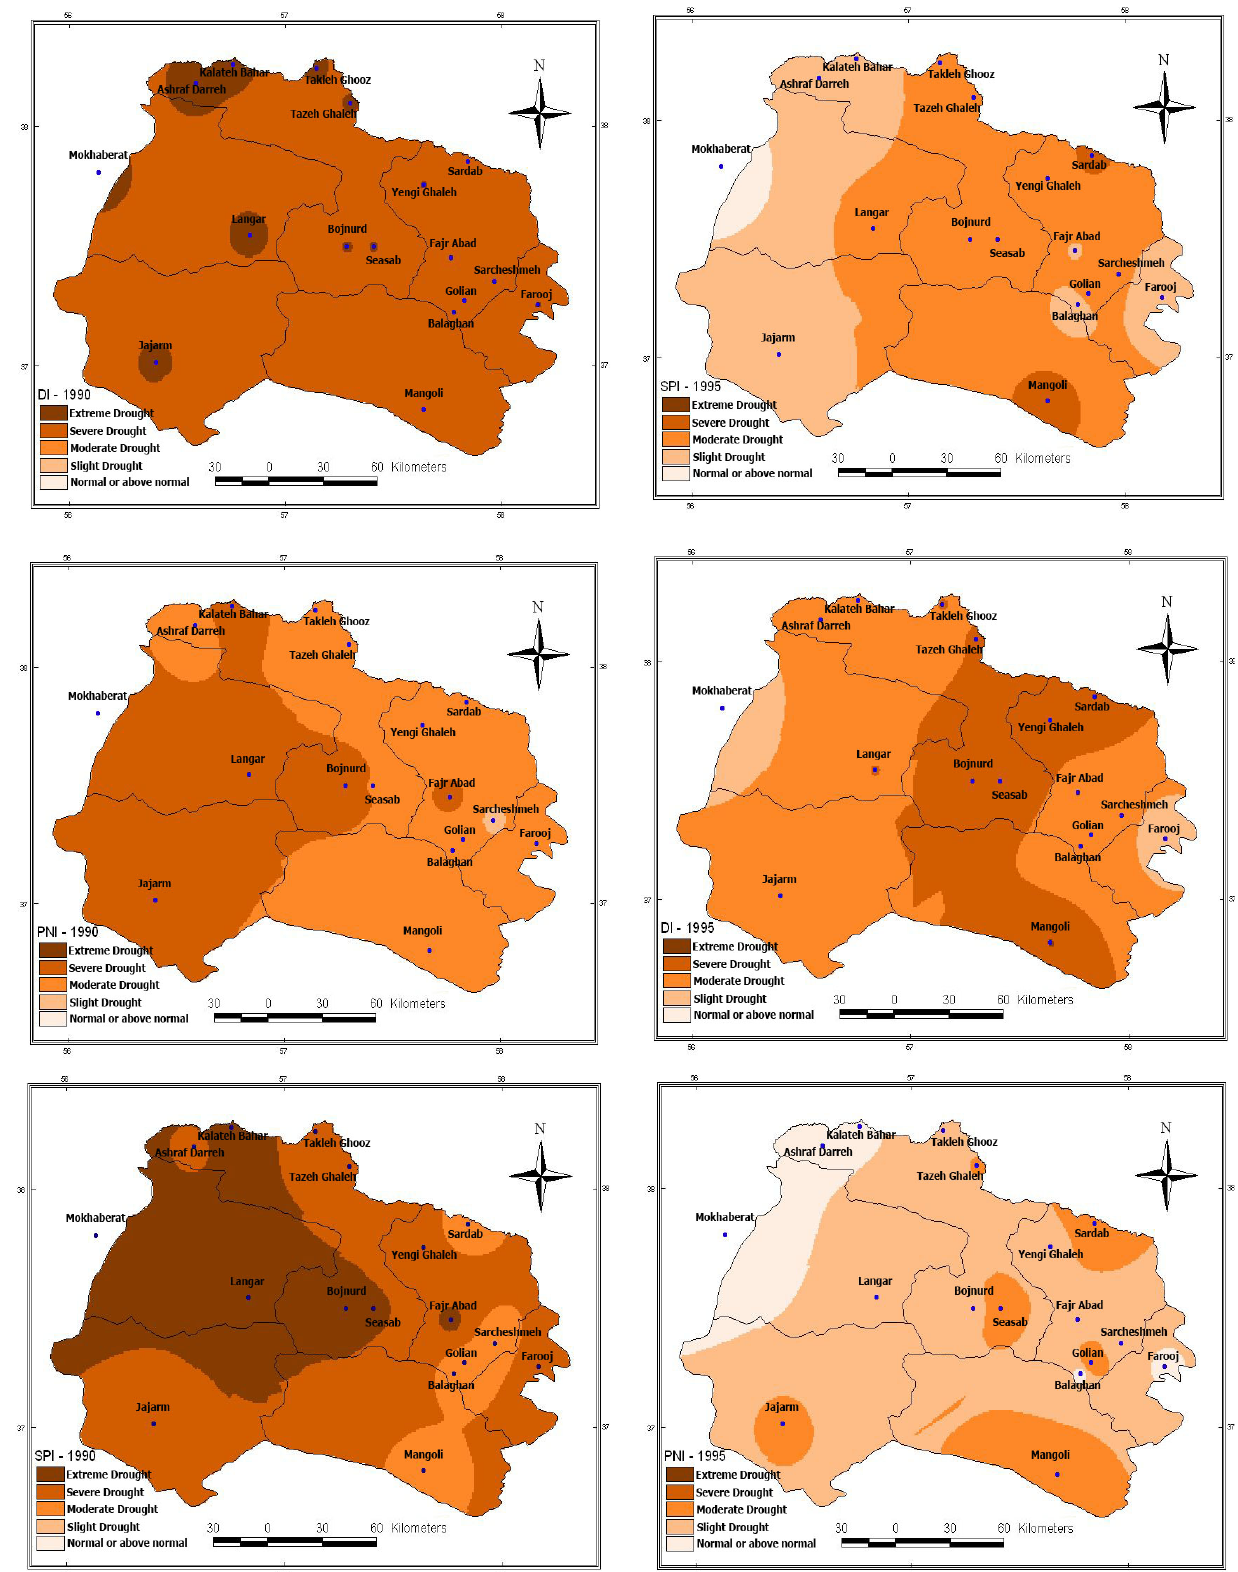
Fig. 3. Drought zone scheme for Northern Khorasan province by SPI ( Standard Rainfall Index) , DI ( Decades Index) and PNI ( Percent of Normal) indices in 1990